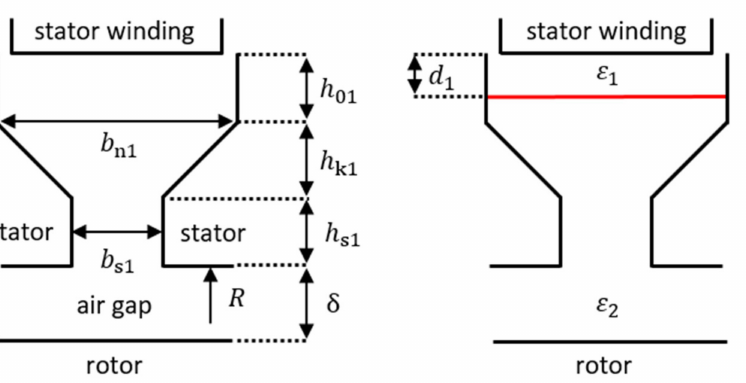
Figure 2. Representation of the slot